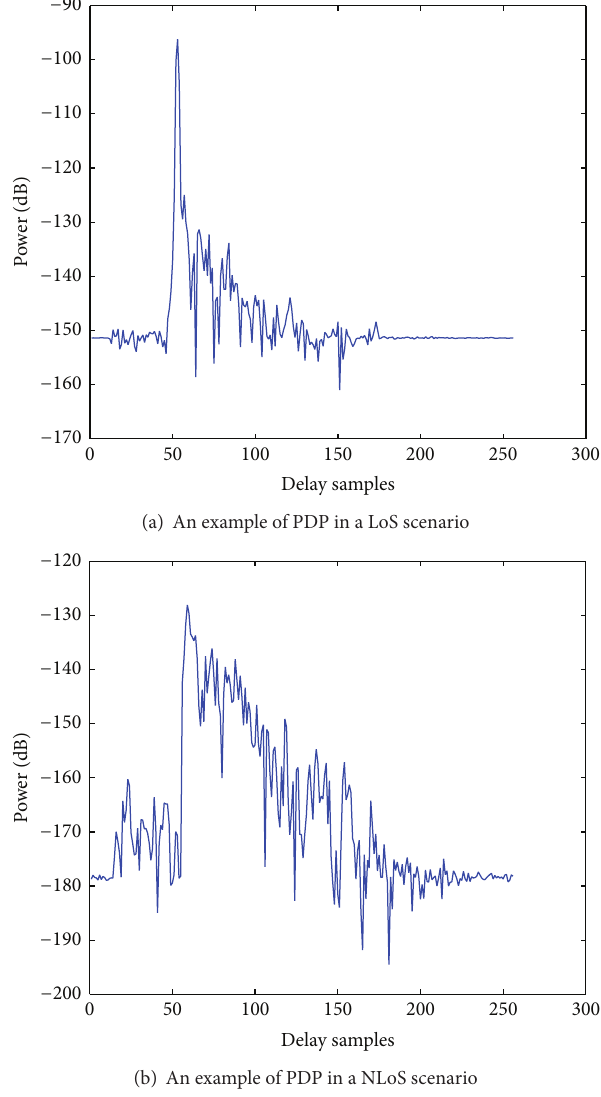
Figure 4: Simulation comparison of PDPs for LoS and NLoS scenarios with similar